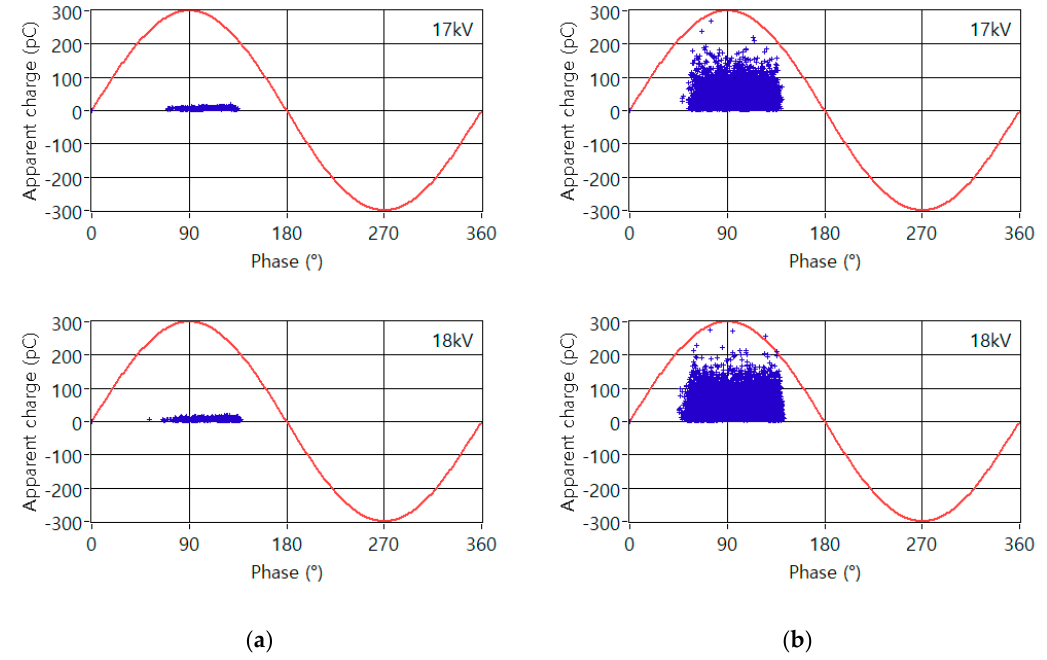
Figure 7. Phase-resolved partial discharge (PRPD) patterns in the POC. ( a ) In SF 6 ; ( b ) In g3.